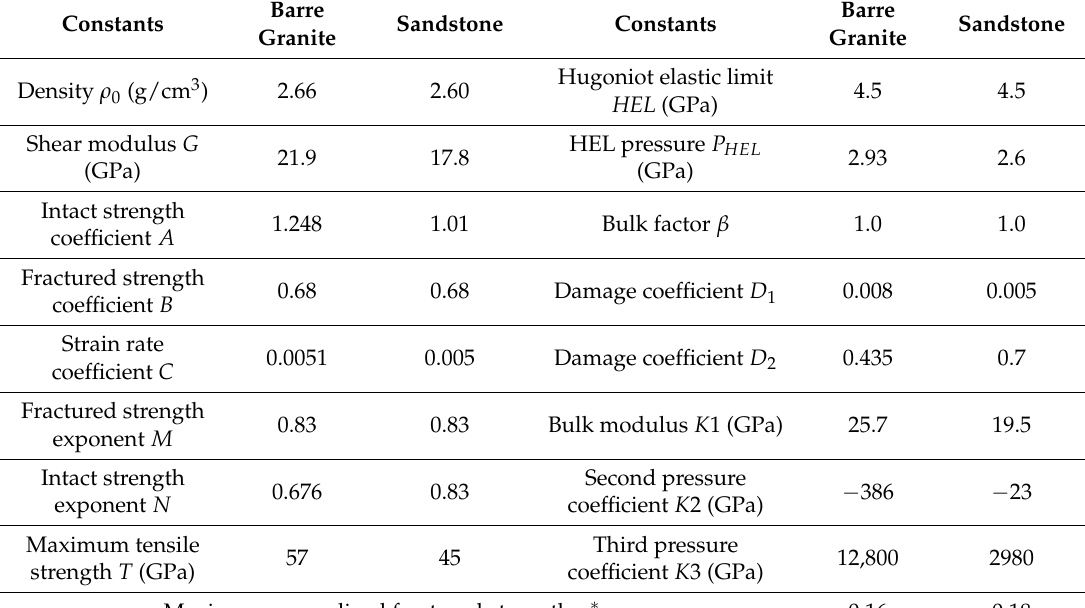
Table 1. Parameters of Barre granite and sandstone